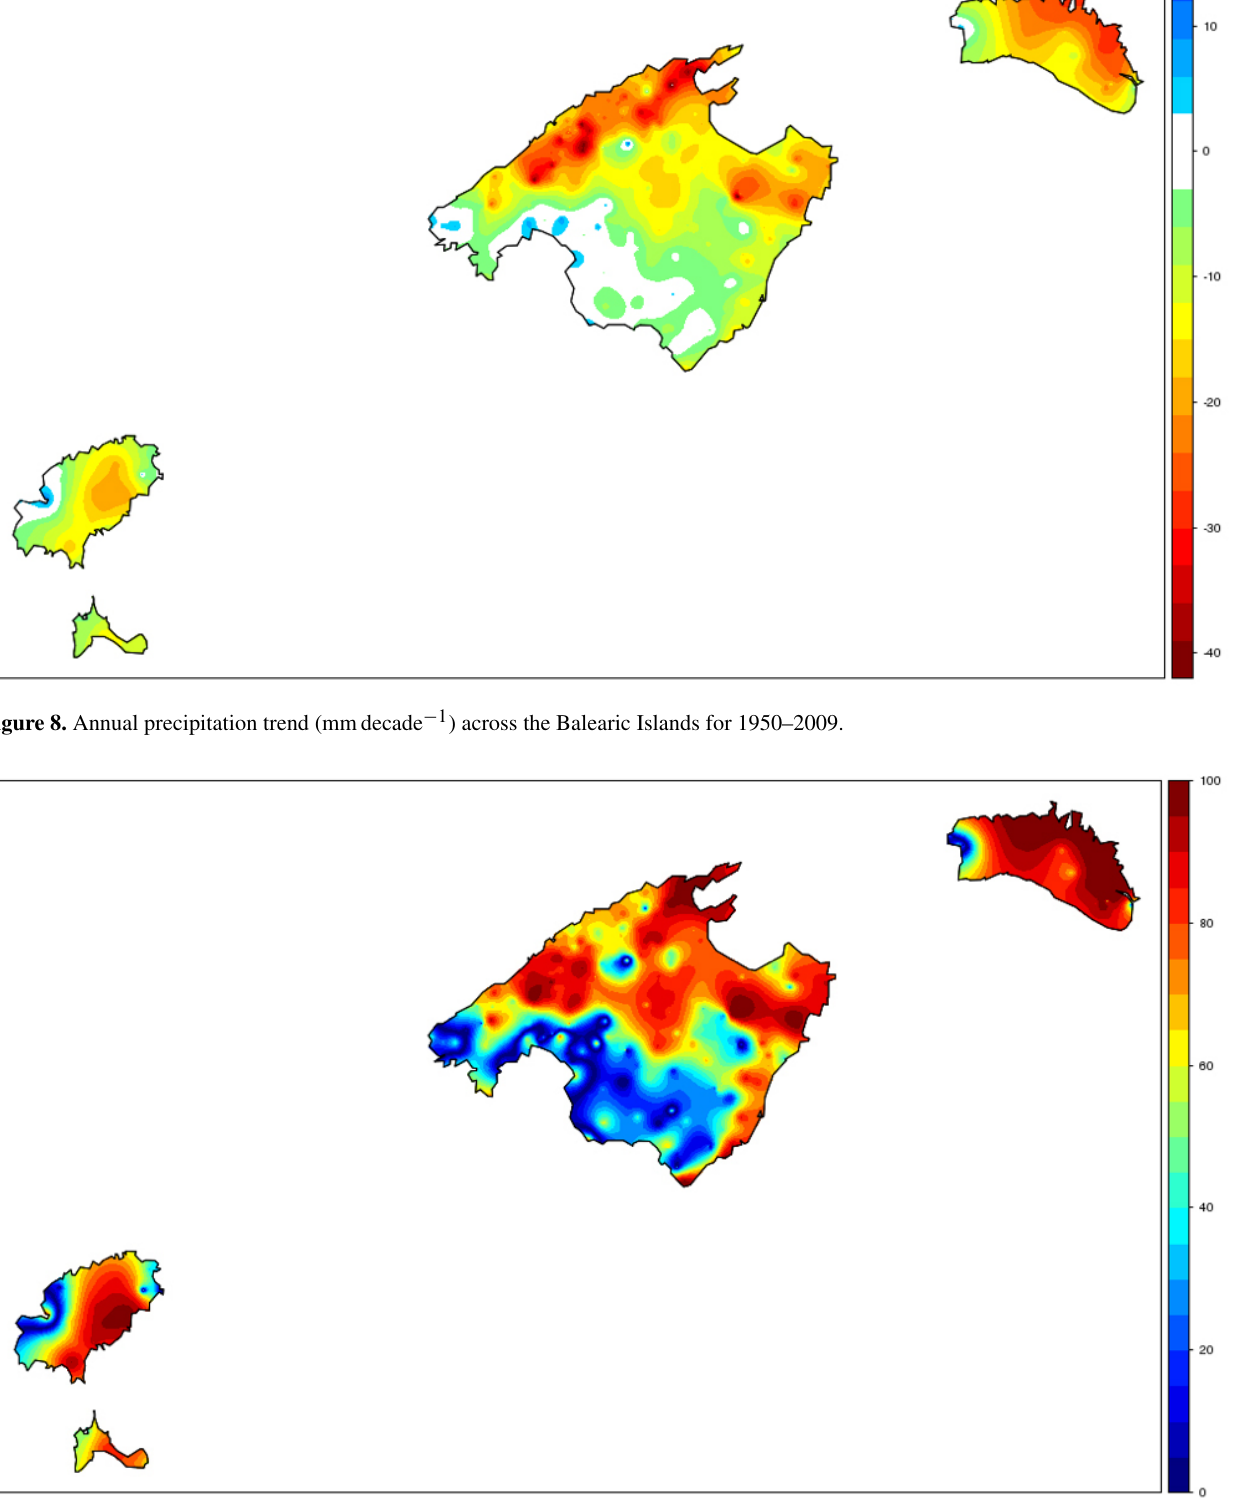
Figure 9. Level of statistical confidence (%) of the annual precipitation trend for